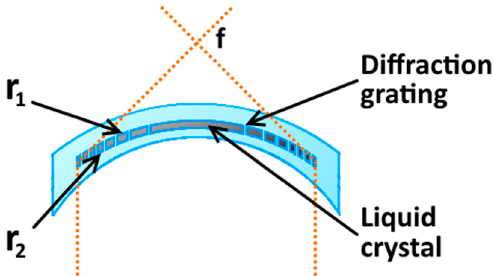
Figure 10. LC cavity split into Fresnel zones, resulting in a diffractive lens. The inner and outer curvatures of the cavity are the same ( r 1 = r 2 ), and their separation creates a phase difference of π .